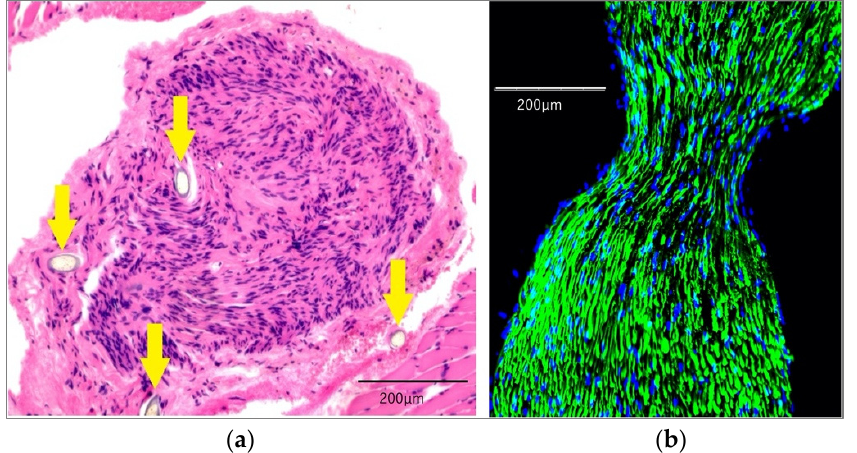
Figure 1. Histological findings of nerves in the suture group. ( a ) The figure shows the distal stump of the masseteric nerve; it was sutured with the hypoglossal nerve. The yellow arrows indicate the nylon sutures used for coaptation. There were no morphologically abnormal findings. These were stained with H&E. ( b ) Immunofluorescence staining of the coaptation area of the hypoglossal nerve and masseteric nerve. All nerves, including the coaptation area, were positive for neurofilament antibodies. Representative immunostaining with neurofilament antibodies (green) was performed using 4 ′ ,6-diamidino-2-phenylindole (DAPI; blue).